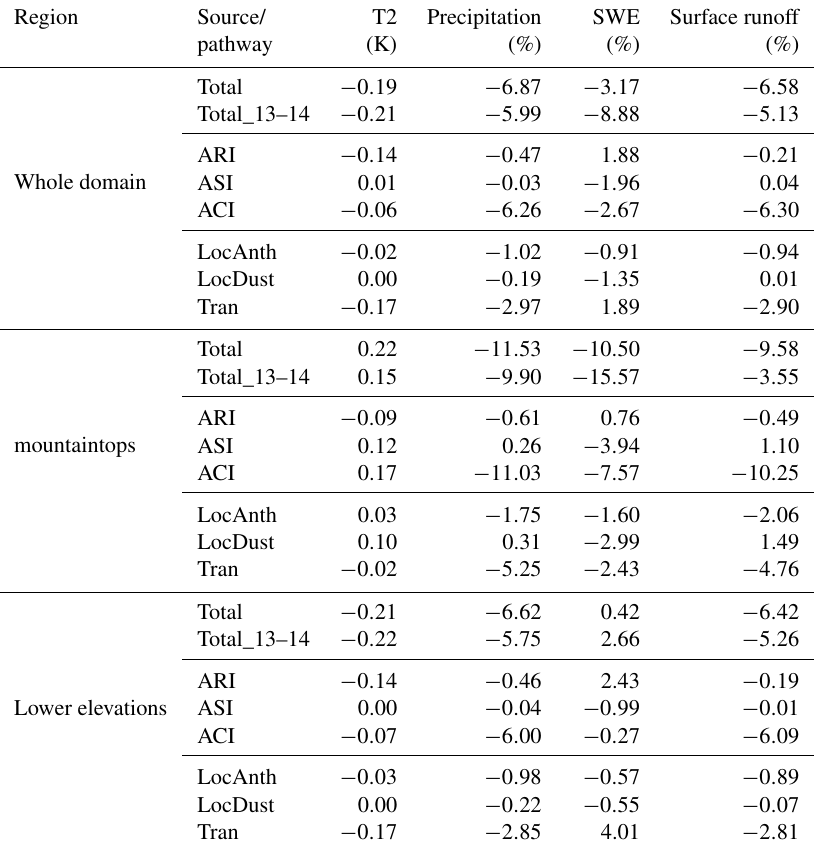
Table 4. Changes in surface temperature (K) and precipitation, SWE, and surface runoff in percentage averaged from October 2012 to June 2013 due to overall and various aerosol effects for the whole domain (34–42 ◦ N, 117–124 ◦ W, not including ocean points), mountaintops (with elevation ≥ 2.5km), and lower elevations (<2.5km). Total impacts for the simulations from October 2013 to June 2014 are also included as